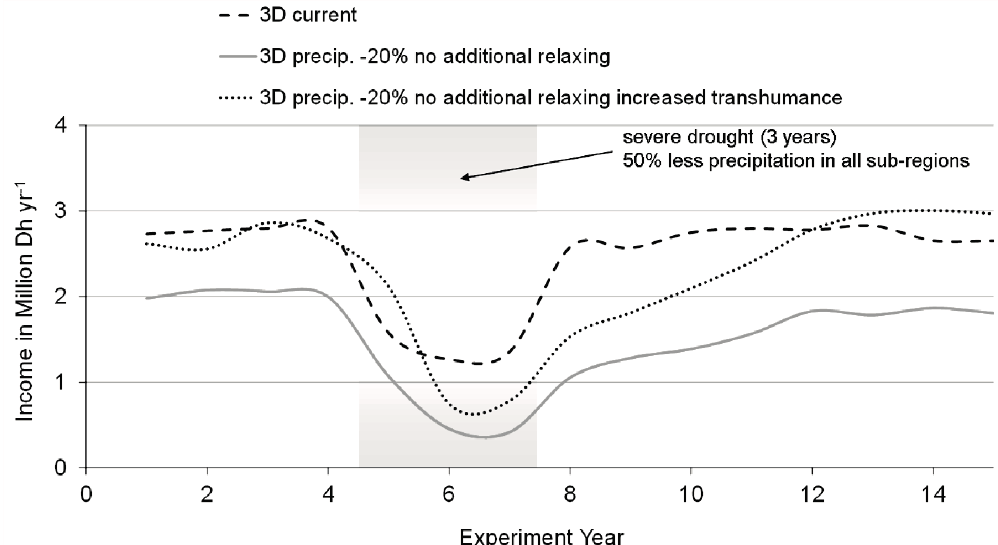
Figure 10. Ensemble means (N = 15) of total annual income from pastoralism in the study region (transhumant + sedentary). The solid grey line displays a lock-in effect of the system, if the model is not allowed to recover for more than 10 years under reduced average